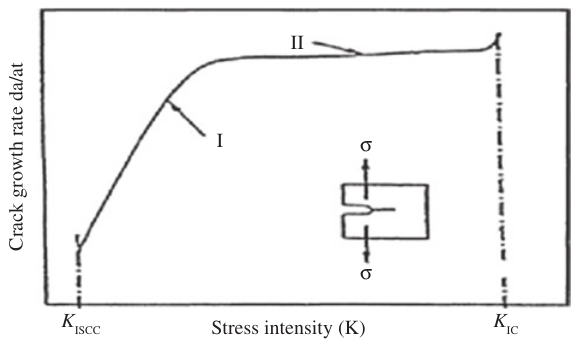
Figure 1: Schematic diagram of general trend of crack growth rate against stress intensity factor